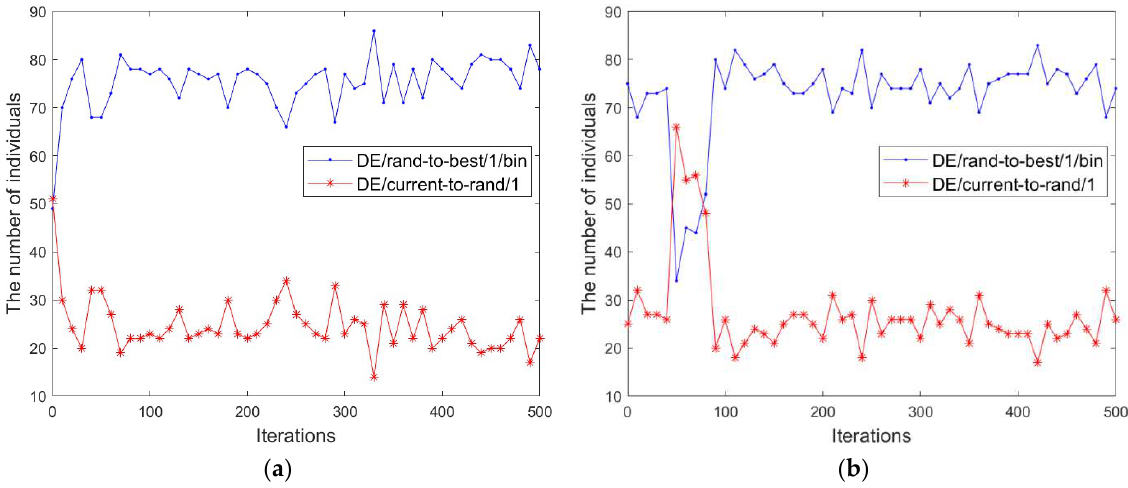
Figure 3. The number of individuals of two generation strategies changes during the whole evolu- tionary process. ( a ) CH5, ( b ) LIR-CMOP9. Table 13. IGD and HV results of two variants on CF5 and LIR-CMOP9.